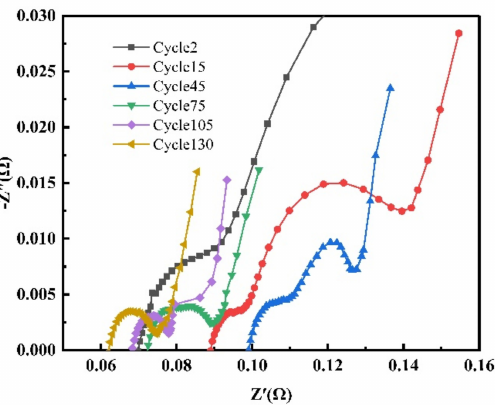
Figure 4. The impedance variation of a -type NCM811 battery during 130 cycles at the cycle ratio of 2 C with the cut-off voltage of 1